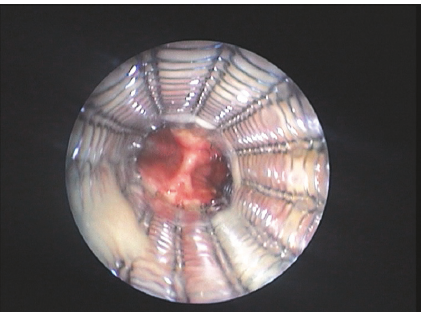
Figure 4: A metal stent in the trachea. This nitinol stent is covered except at the ends. The image is from another